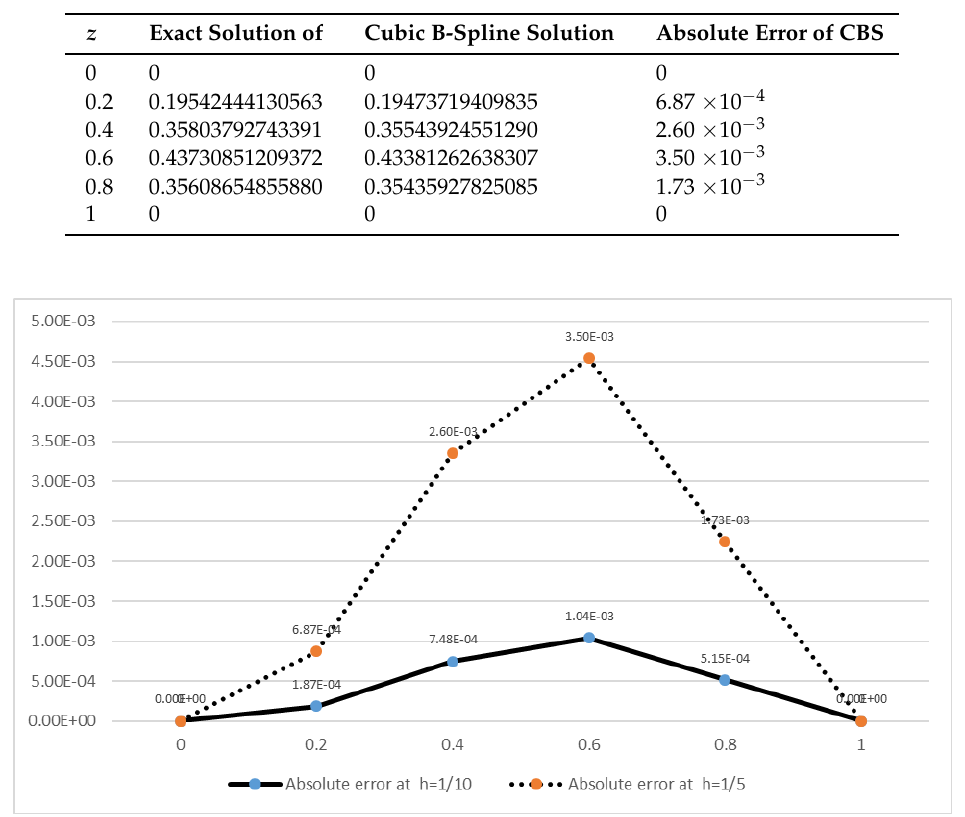
Table 6. Comparison of exact solution and Cubic B-spline solution of Problem 2 at h = 1